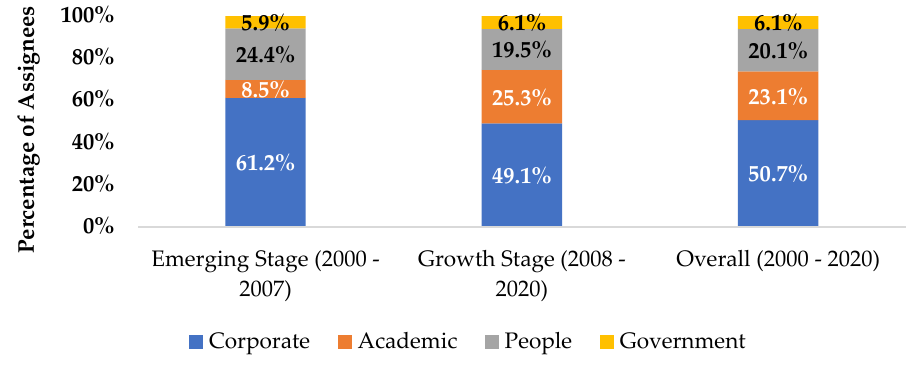
Figure 6. Four types of assignees in view of the technology life cycle.